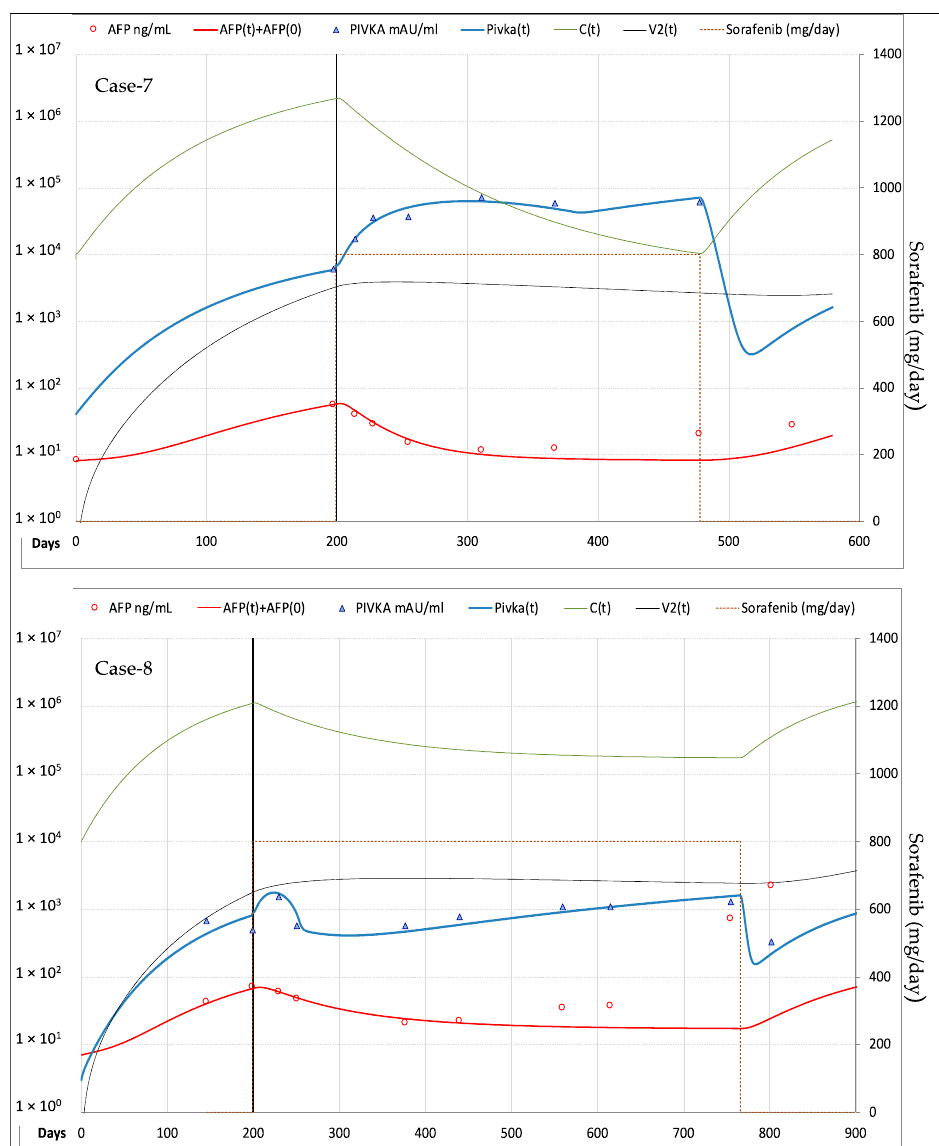
Figure 8. Best fitting of AFP and PIVKA-II serum levels in the 2 patients with SD of the target lesion, but overall progression due to the appearance of new lesions after 9.3 and 18.9 months of therapy. Legend : AFP = measured AFP; AFP(t) = model computed AFP; AFP(0) = AFP normal value; PIVKA-II = measured PIVKA-II; Pivka(t) = computed PIVKA-II; C(t) = model computed cancer cells; V2(t) = model computed vascularization index.